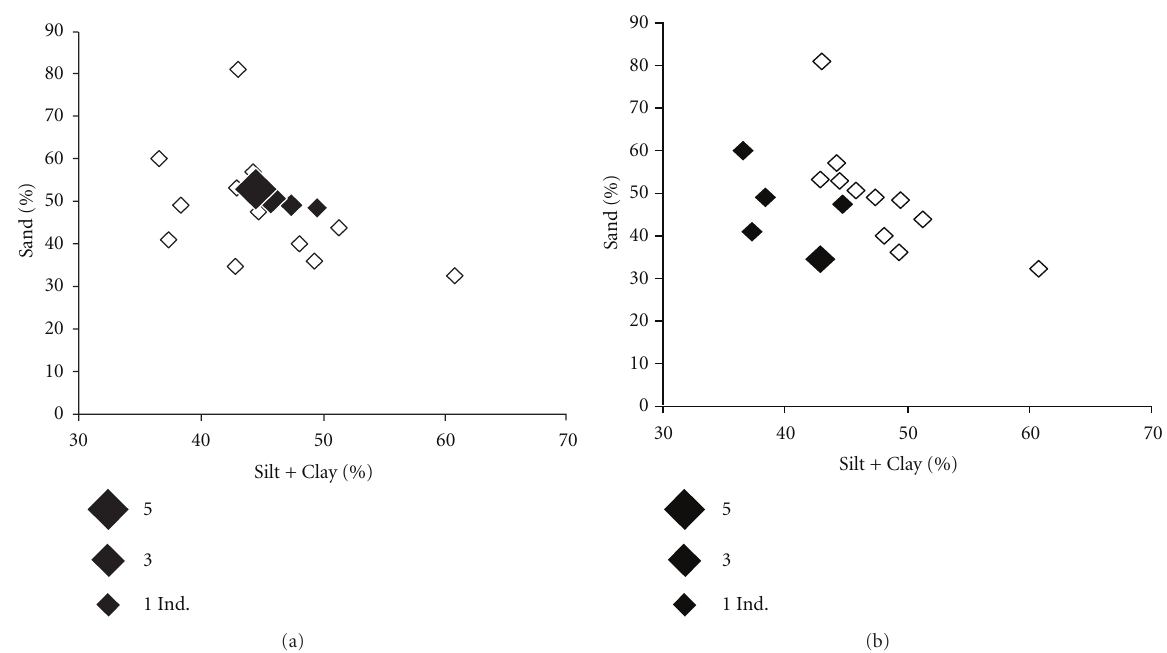
Figure 3: Occurrence of Bledius defensus (a) and Anotylus insecatus (b) in the sand-silt/clay relationship of woodless cli ff s.